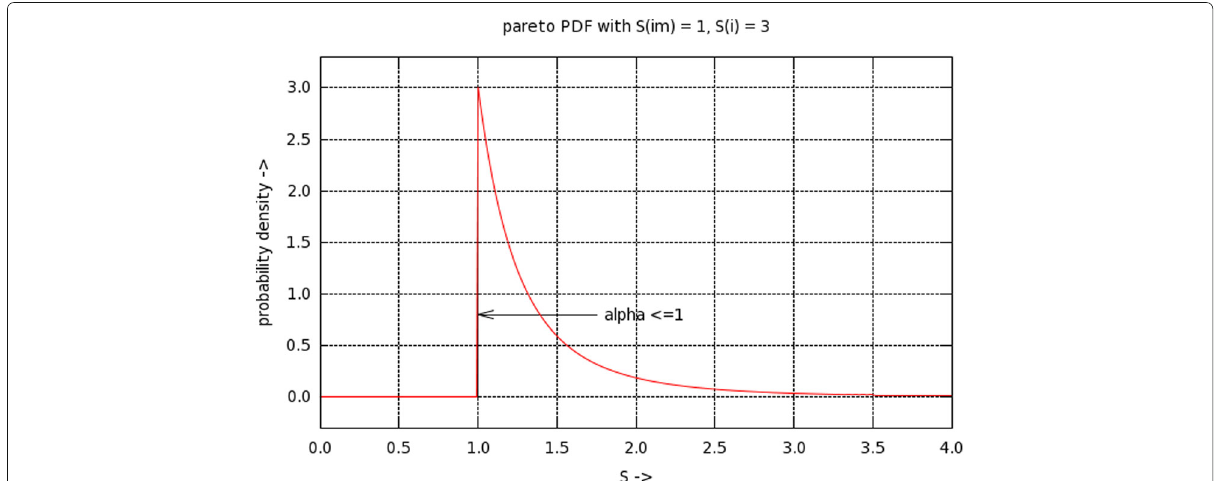
Fig. 8 PDF with S im = 1 and S i = 3